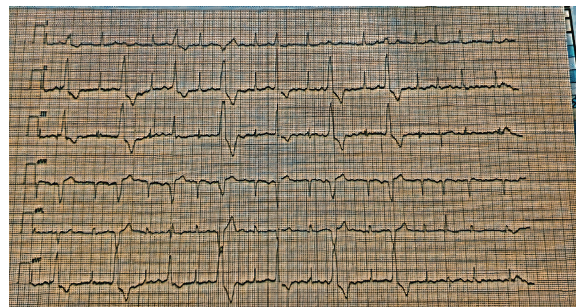
Figure 3: ECG disclosing AF and multifocal ventricular ectopic beats due to the aberrant conduction of atrial